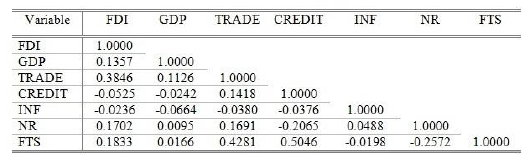
Table 2: Correlation Analysis